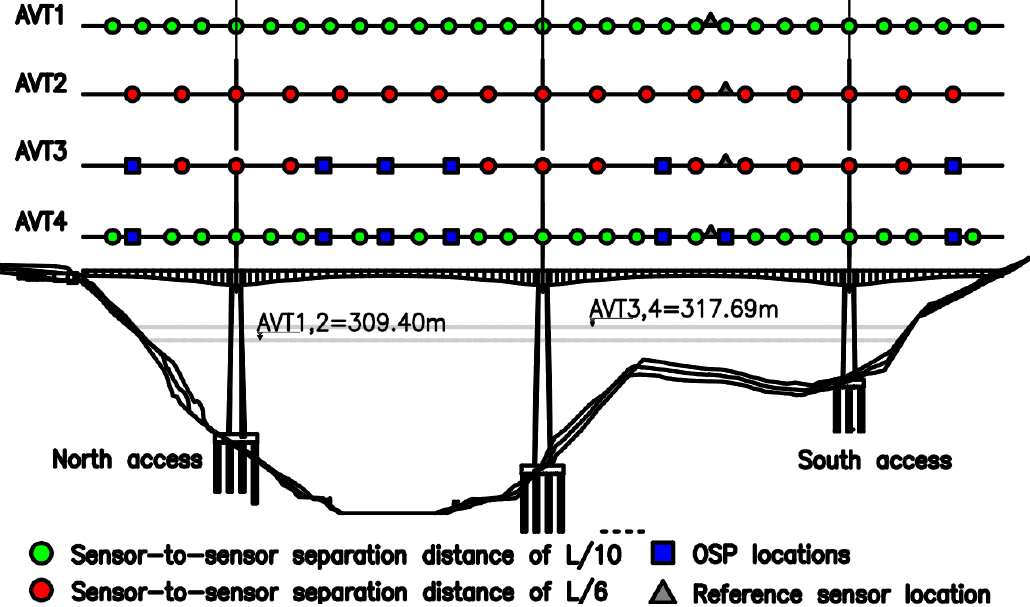
Figure 12. Location of sensors in the four days of tests and the level of water measured in the field.